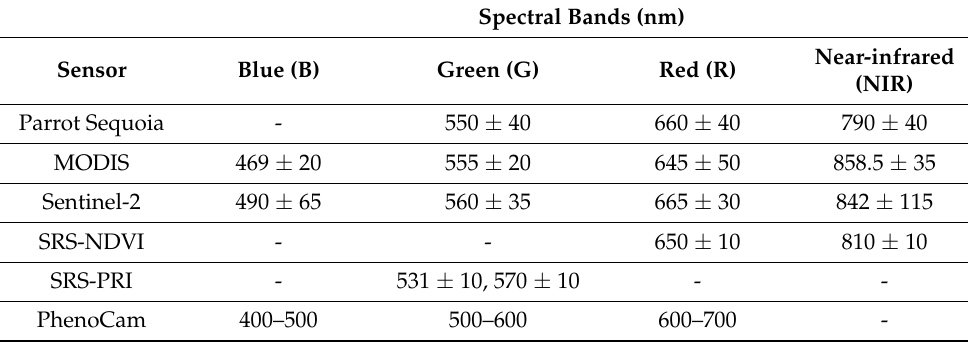
Figure 2. 3DR SOLO UAV and Parrot Sequoia multispectral sensor [41] (left) carried on the Solo 3DR quadcopter [42] (right). The Parrot Sequoia camera is designed to acquire images in four spectral bands: green (G), red (R), Red Edge (RE) and near-infrared (NIR), with wavelengths specified in Table 1. The multispectral camera was installed under the drone facing the forest canopy. The images were captured by 1.2 MP monochrome sensors at a bit depth of 16 bit in raw format and later saved as .tif files. Table 1. Spectral band information for the near-surface multispectral sensors (Parrot Sequoia onboard UAV and Spectral Reflectance Sensors), satellite spectrometers (MODIS and Sentinel-2) and RGB PhenoCam. Only the spectral bands which were used in the research are mentioned here.